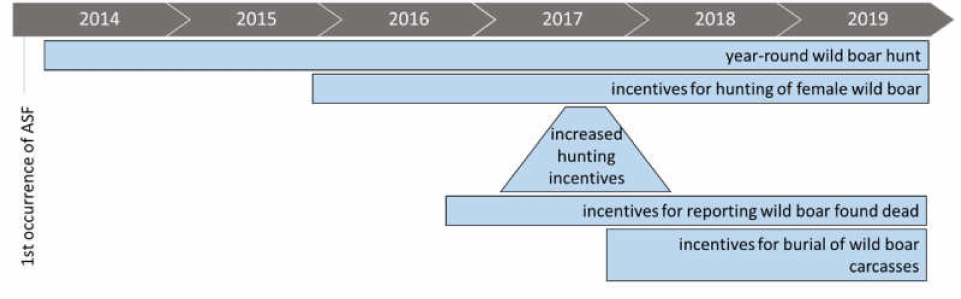
Figure 7. Timeline of disease control measures implemented in Lithuania